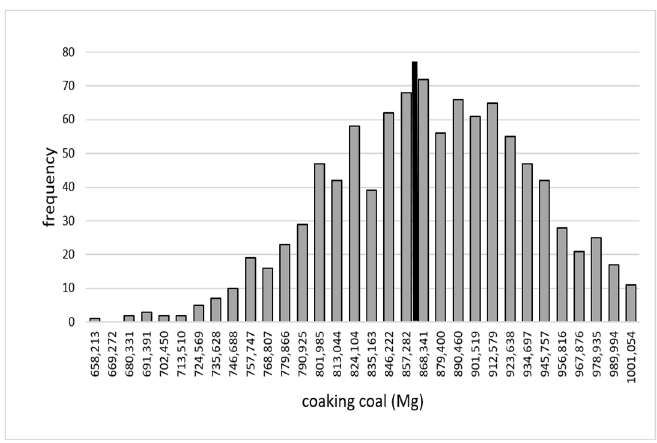
Figure A6. Histogram showing frequencies of achieving given quantity of sales of coking coal (“Cokerys 3”) for mine “C” with σ yprog .